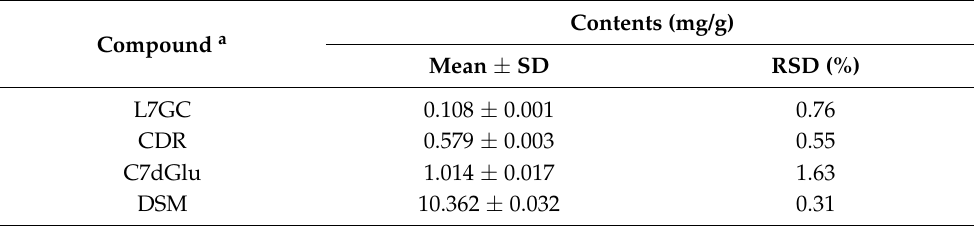
Table 5. Contents of L7GC, CDR, C7dGlu, and DSM marker compounds in L. chinensis extract sample ( n = 5). Contents (mg/g) Compound a Mean ± SD RSD (%) L7GC 0.108 ± 0.001 0.76 CDR 0.579 ± 0.003 0.55 C7dGlu 1.014 ± 0.017 1.63 DSM 10.362 ± 0.032